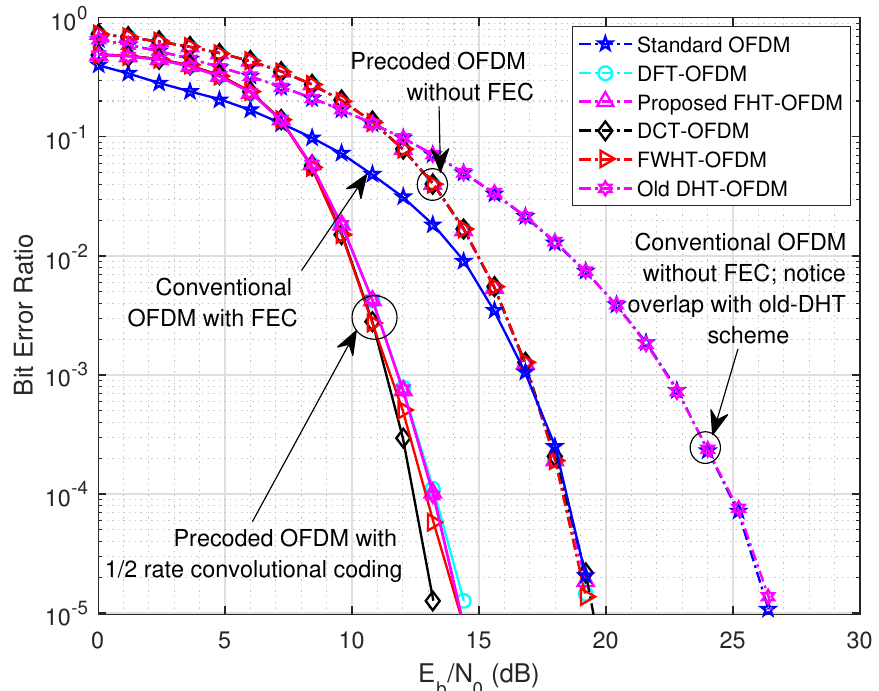
Figure 10. BER results of precoded OFDM (with convolutional coding) over frequency-selective fading channel corrupted by AWGN ( (cid:96) h = 3 channel taps).